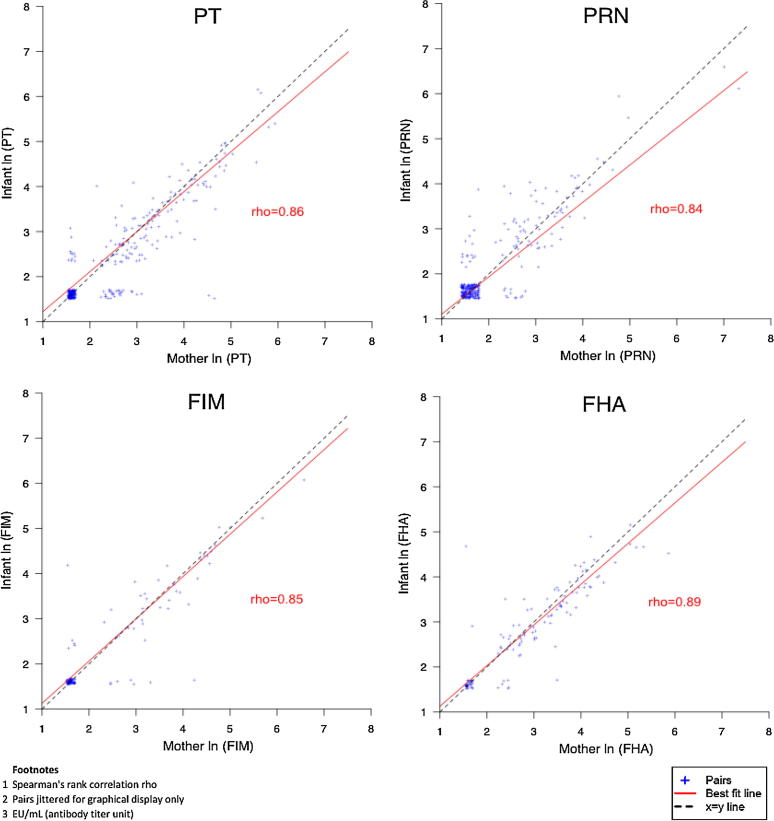
Association of mother and infant pertussis antibodies at birth.